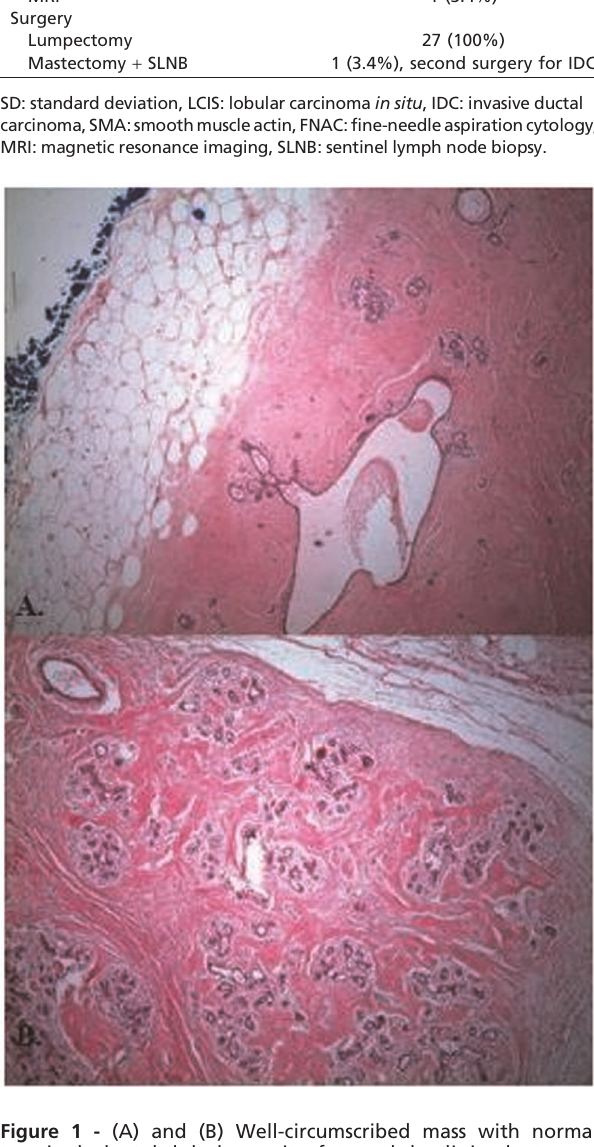
Figure 2 - Ductal epithelial hyperplasia, (H&E), 6 100.